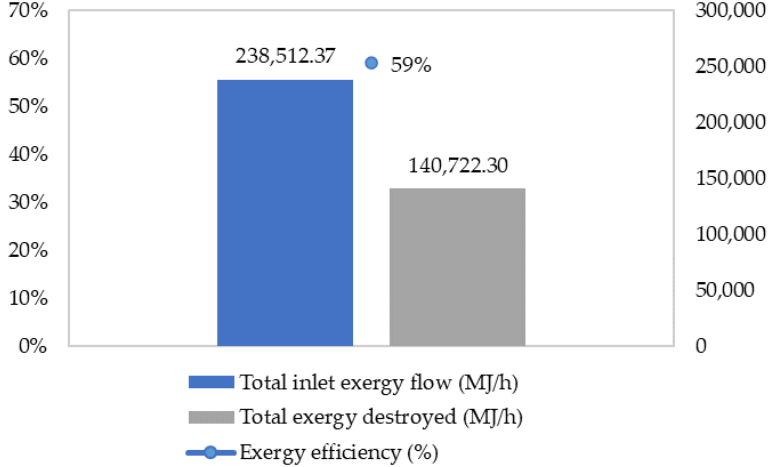
Figure 5. Exergy efficiency of the crude oil production process. Adapted from [11].